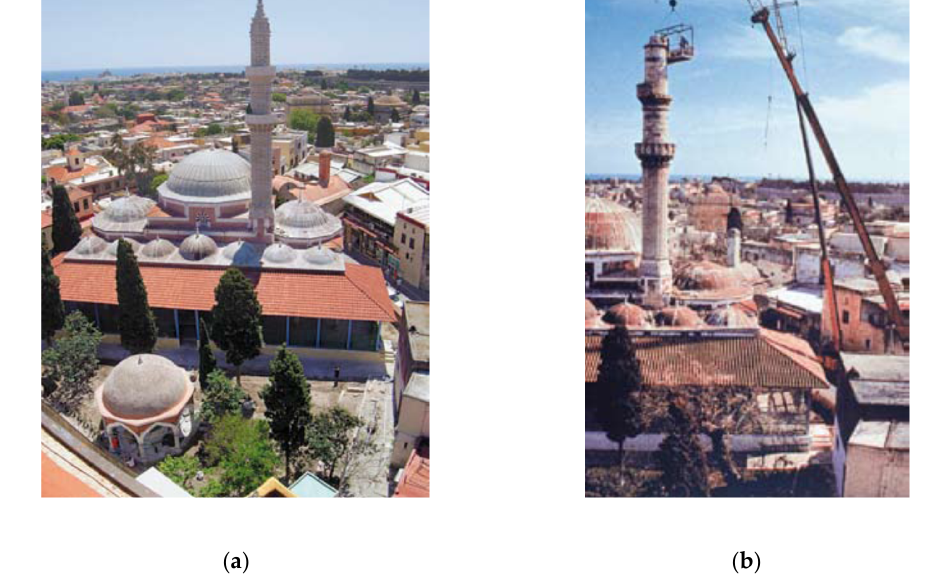
Figure 2. ( a ) Suleiman Mosque of the medieval city of Rhodes, ( b ) rebuilding of the minaret due to the advanced decay of its sandstone blocks [46].